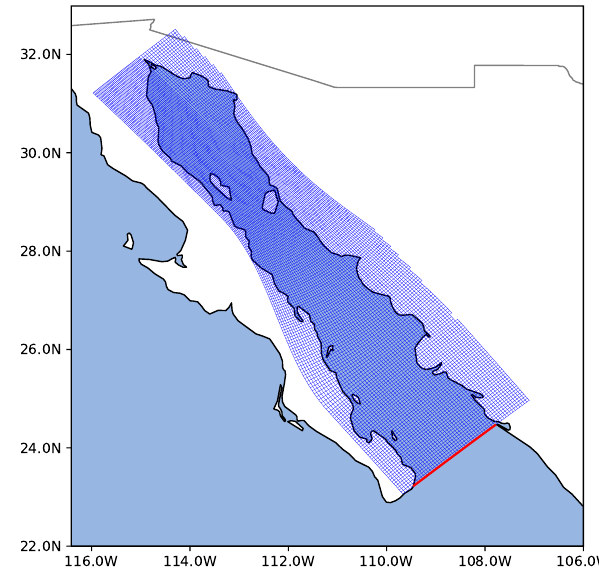
Figure 1. Computational grid with variable resolution. In the cross-Gulf direction the resolution varies from 2.55 km to 5.621 km and in the long-Gulf direction from 3.073 km to 6.465